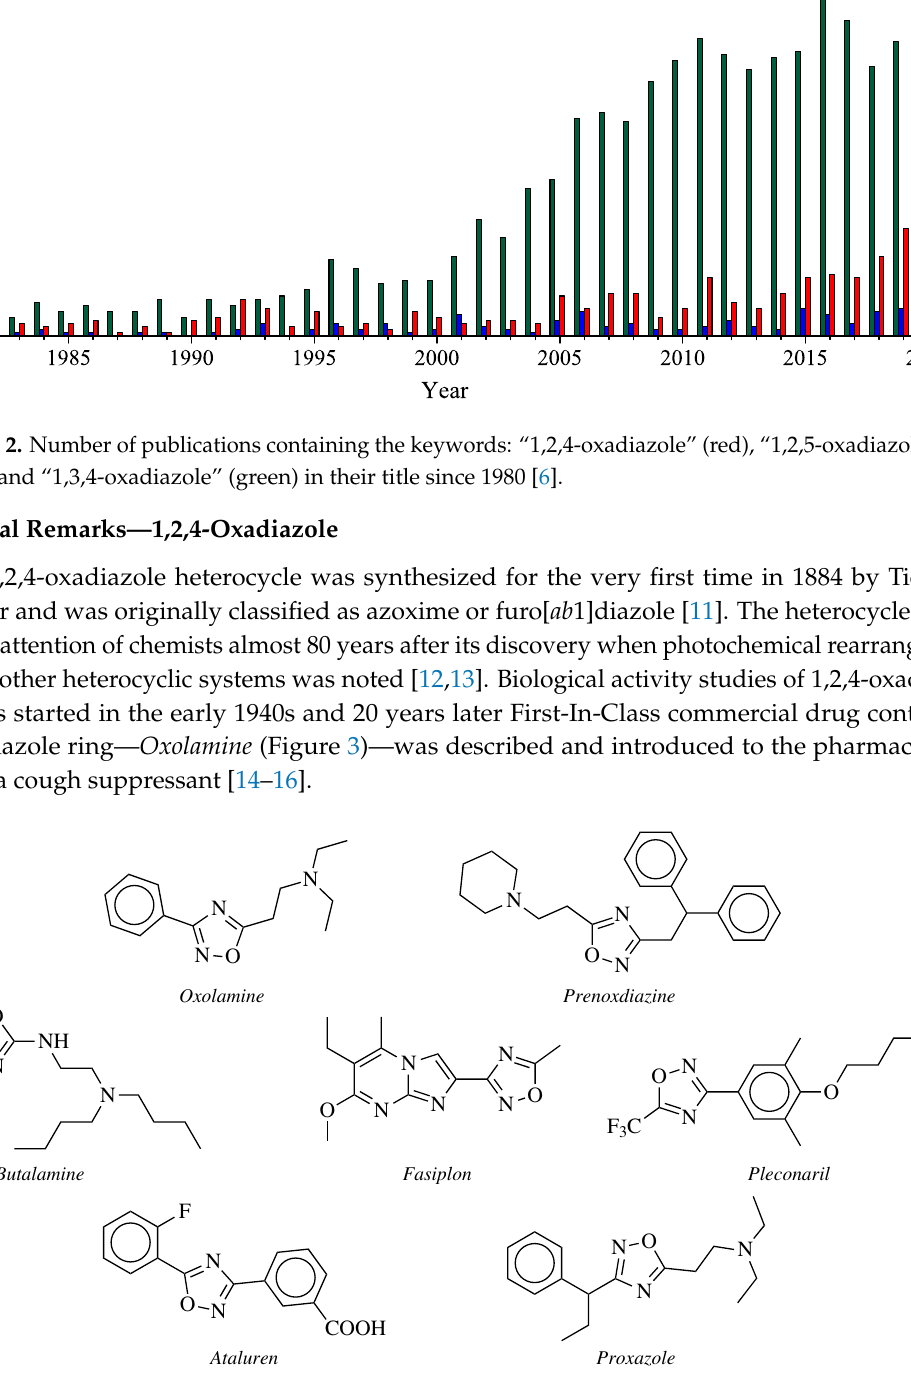
Figure 3. Chemical structures of commercial drugs based on a 1,2,4-oxadiazole